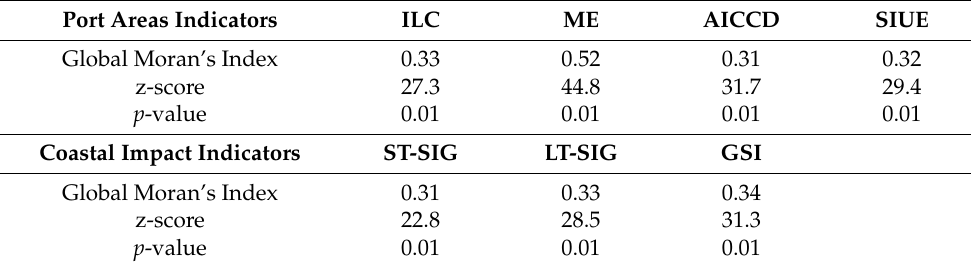
Table 5. Global Moran’s I statistic for port configuration and coastal impacts indicators in the study area. Port Areas